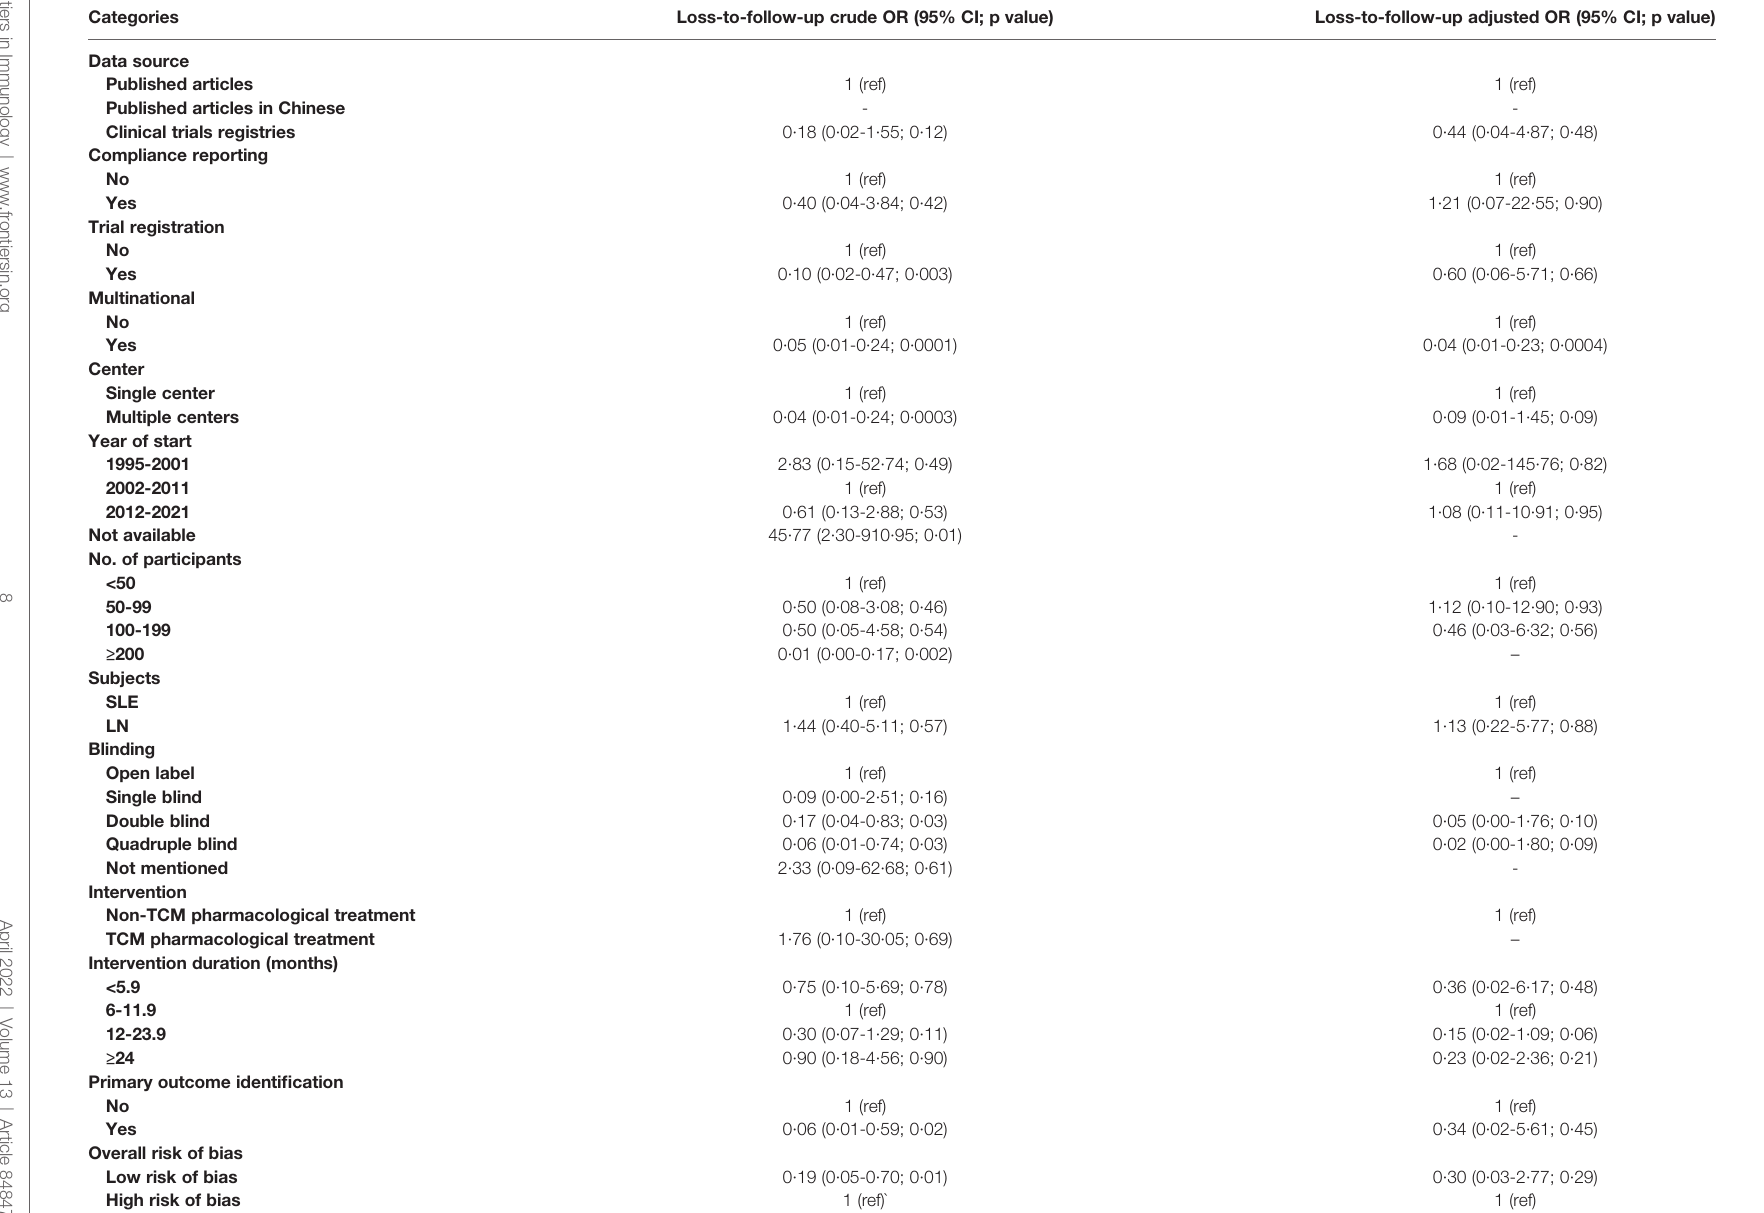
TABLE 2 | Crude and adjusted ORs for factors associated with less than 10% participant loss in multinational studies or in single-country studies conducted in non-mainland